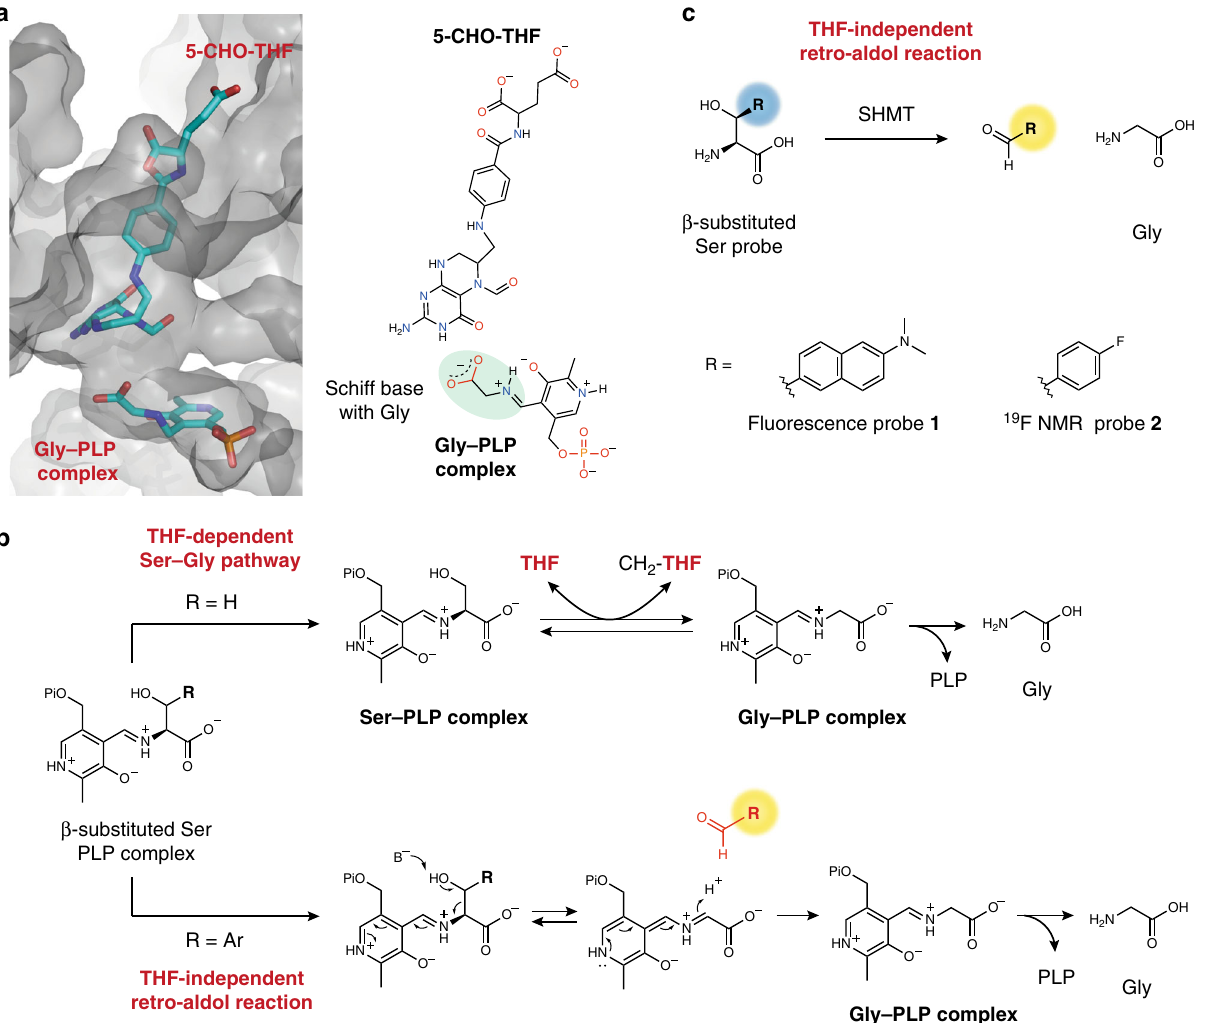
Fig. 2 Molecular design of hSHMT probes. a Substrate binding site of SHMT1. Illustration of the SHMT1 – 5-CHO-THF – Gly-PLP complex from crystal structure data (Mouse SHMT, PDB ID: 1EJI). 5-CHO-THF and Gly-PLP are shown as stick models. Color code: oxygen: red; nitrogen: blue; carbon: cyan; phosphorus: orange. b The proposed mechanism of SHMT. (upper) THF-dependent serine – glycine pathway and (lower) THF-independent retro-aldol reaction catalyzed by SHMT. Pi = -PO 3 2 – . c Fluorescent probe 1 and 19 F NMR probe 2 used in this